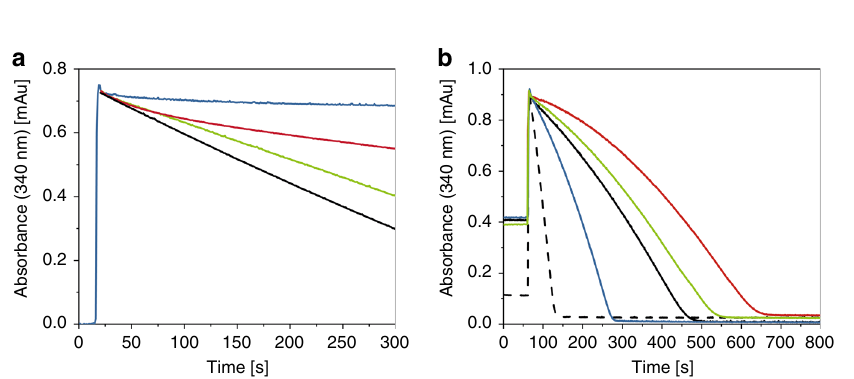
Fig. 6 NADH-dependent activities of complex I (black) and the G135D E (red) and the G135S E (green) variant. a NADH:decyl-ubiquinone oxidoreductase activity measured as decrease of the NADH absorbance at 340 nm. The change in absorbance without any protein in the assay is shown in blue. Assay conditions: 5 µ g of protein, 60 µ M decyl-ubiquinone, 60 µ M NADH in 1 ml (total volume) 50 mM MES/NaOH, 50 mM NaCl, 0.1% (w/v) dodecyl- maltoside, pH 6.0. b NADH/ferricyanide oxidoreductase activity measured as decrease of the NADH absorbance at 340 nm. The reaction was either started by an addition of 150 µ M NADH (dashed line) or 1 mM ferricyanide (solid lines). The rate of the reaction started by NADH addition was 350 ± 10 s – 1 for all samples. The rates of the reaction started by an addition of ferricyanide were different for all samples and showed a turnover-dependent activation. For comparison, the activity of the V96P/N142M E variant is shown in blue. Assay conditions: 5 µ g of protein in 1 ml (total volume) of the buffer described above. Source data are provided as a Source Data fi